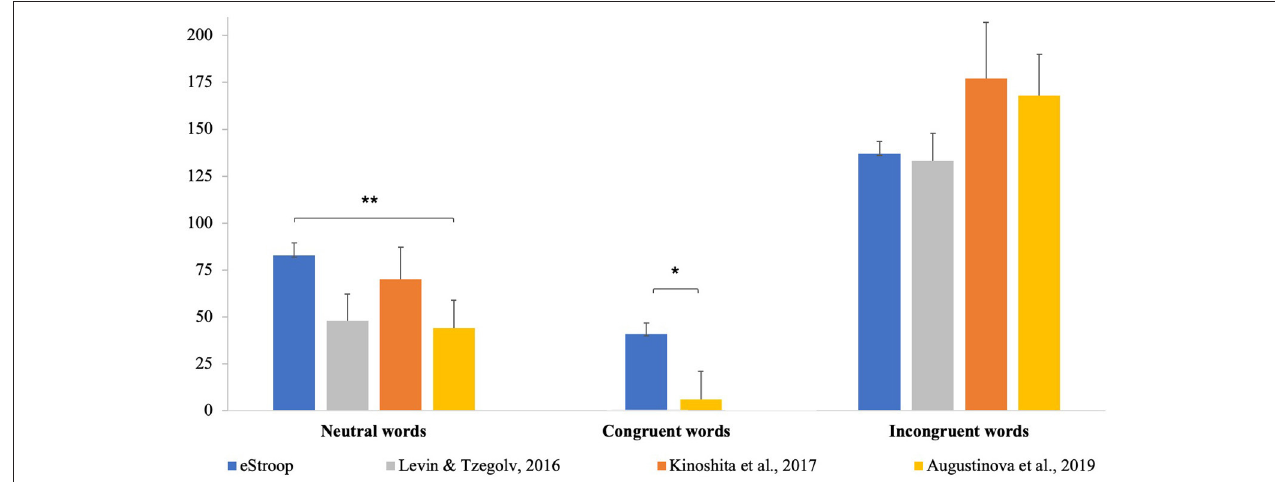
FIGURE 2 | Chart of delta values in ms (the subtraction of mean values of the shapes/strings conditions from the neutral, congruent, and incongruent conditions in all studies). *, significant differences ≤ 0.05; **, significant differences ≤ 0.01.